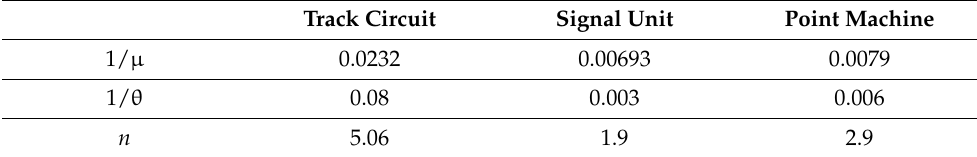
Table 2. Numbers of inspections of different signalling subsystems by Model